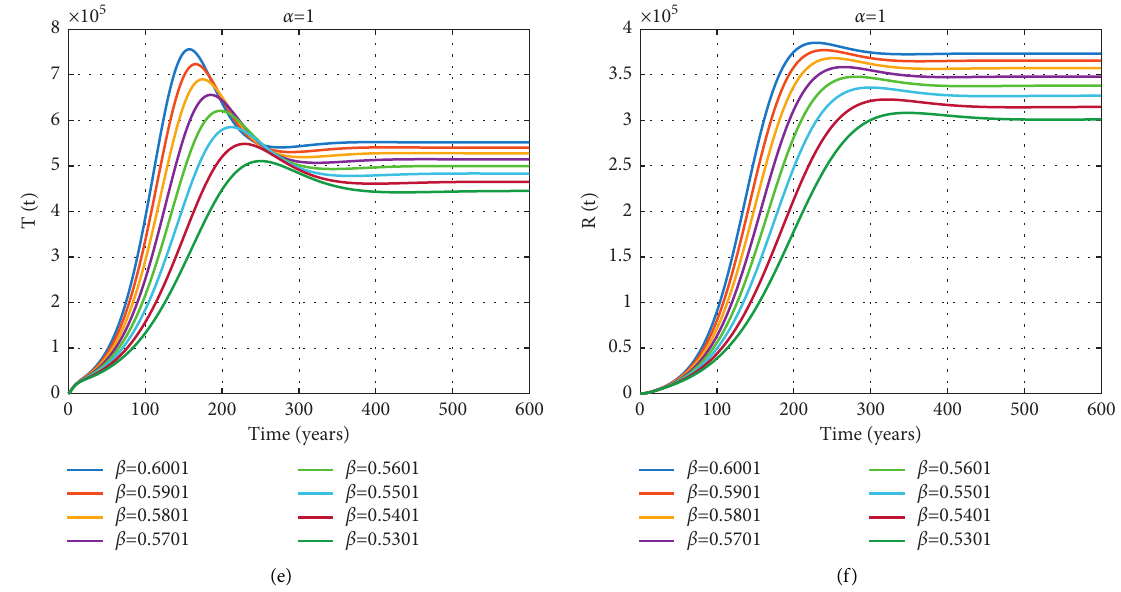
Figure 4: Behavior of the TB model with an impact of contact rate β at α �